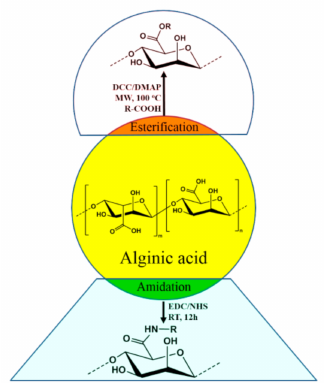
Figure 4. Derivatization of alginic acid via esterification and